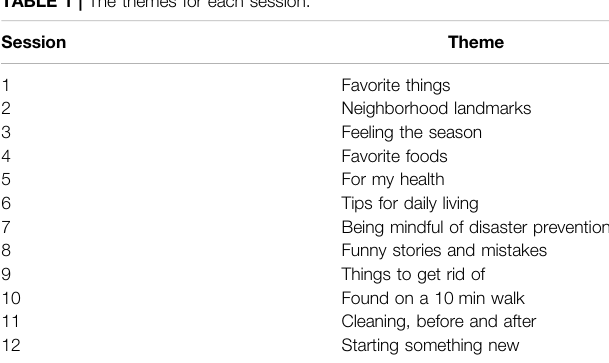
TABLE 1 | The themes for each